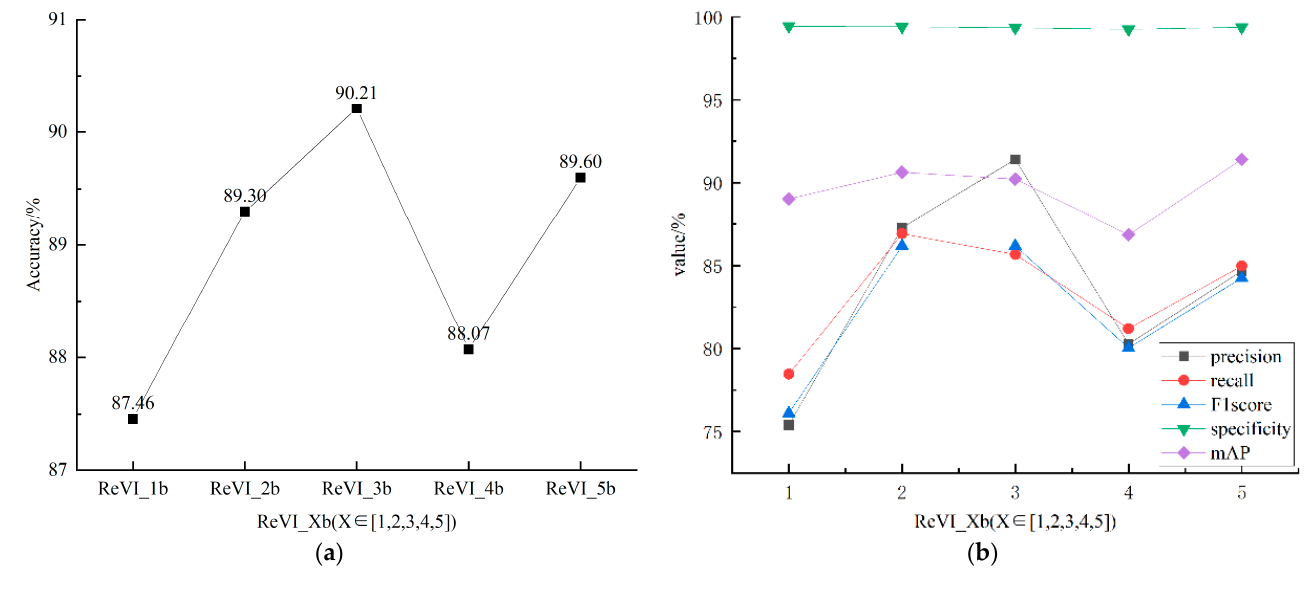
Figure 7. The performance of the ReVI models: ( a ) accuracy variation curve of the ReVI_Xb(cid:4666)X ∈ [1,2,3,4,5](cid:4667) ; ( b ) average accuracy, average recall and average F1-score and average specificity varia- tion curves of the ReVI_Xb(cid:4666)X ∈ [1,2,3,4,5](cid:4667)